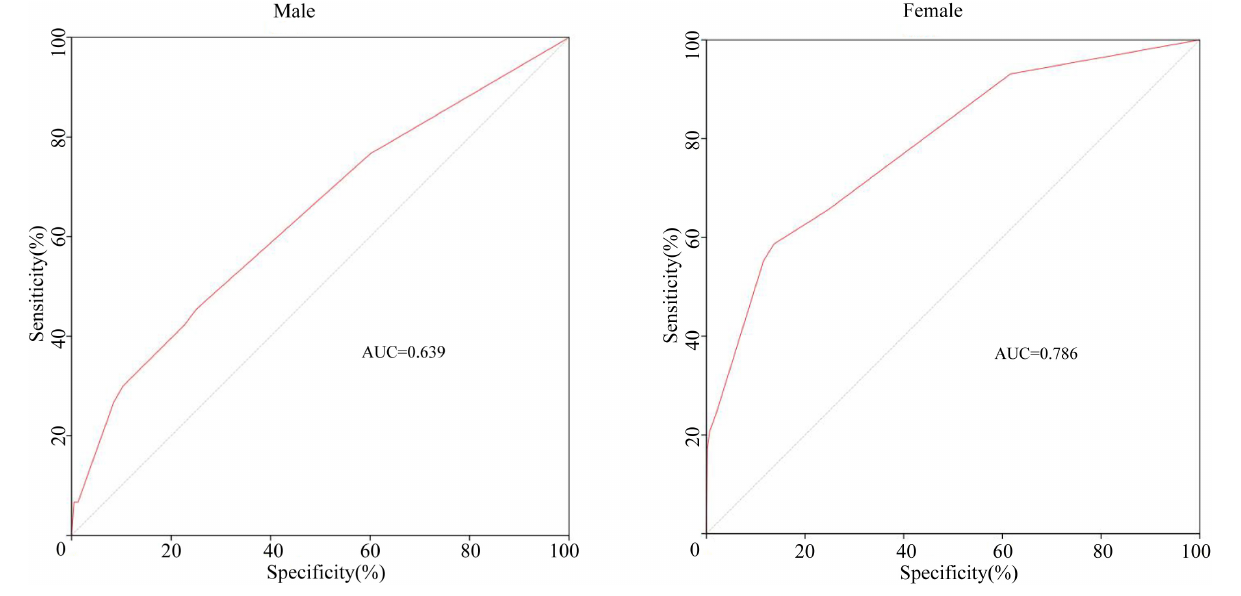
Frontiers in Cardiovascular Medicine |